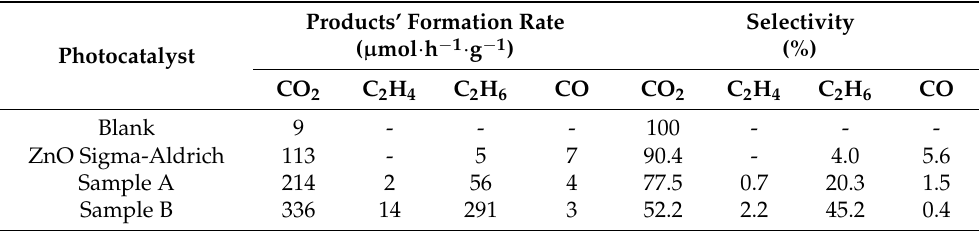
Table 2. Products’ formation rates of ZnO and Pd (1.0%)/ZnO photocatalysts synthesized by ARM and BRM